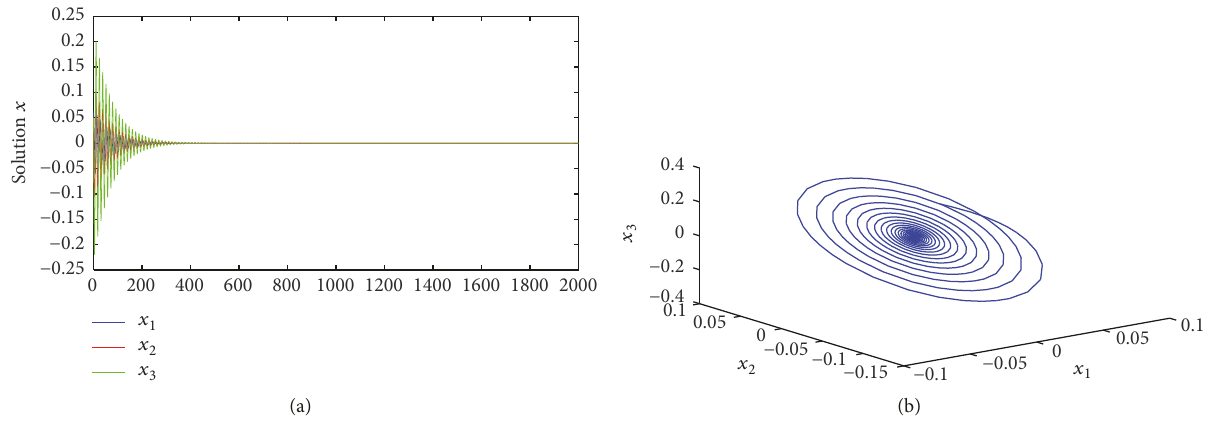
(𝑡) . (b) The phase portrait with 𝜏 𝑖